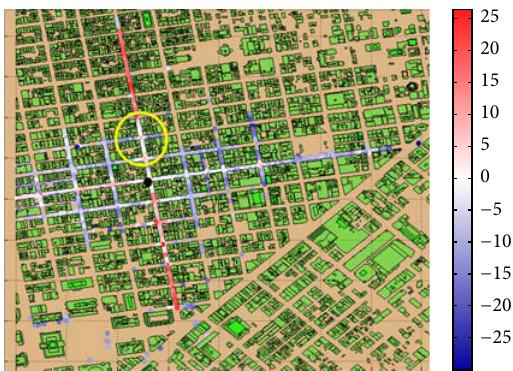
Figure 5: Map of the error [dB] for site A0000F8D. BS position is shown as a black dot.